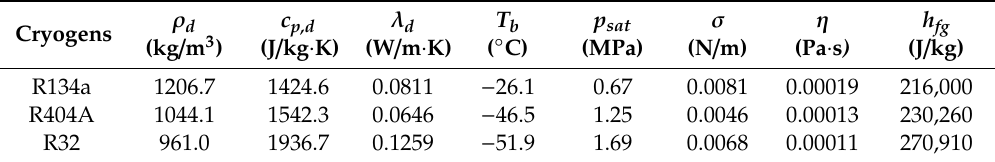
Table 1. Physical properties of R134a, R404A and R32 (25 °C, 1 atm).